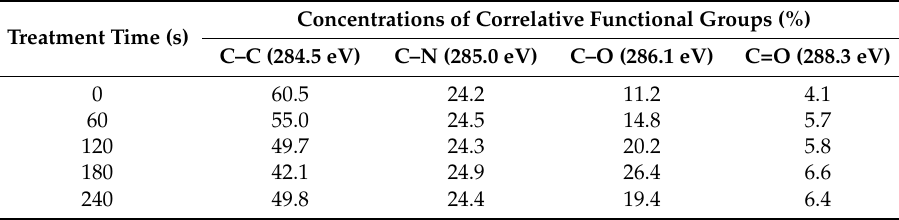
Table 2. The content of functional groups of PI filaments with and without O 2 plasma treatment.